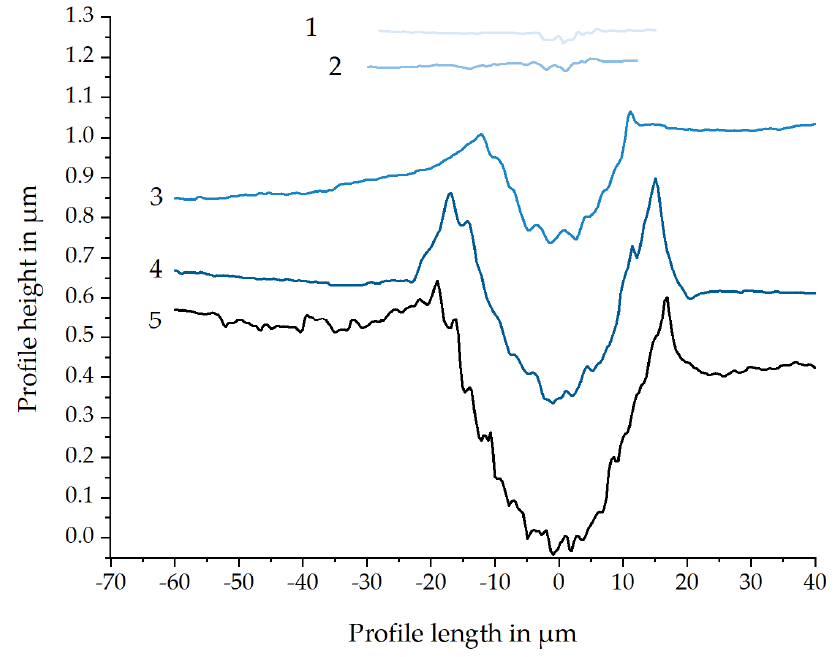
Figure 3. Profiles across wear track 1 at the positions indicated in Figure 2.